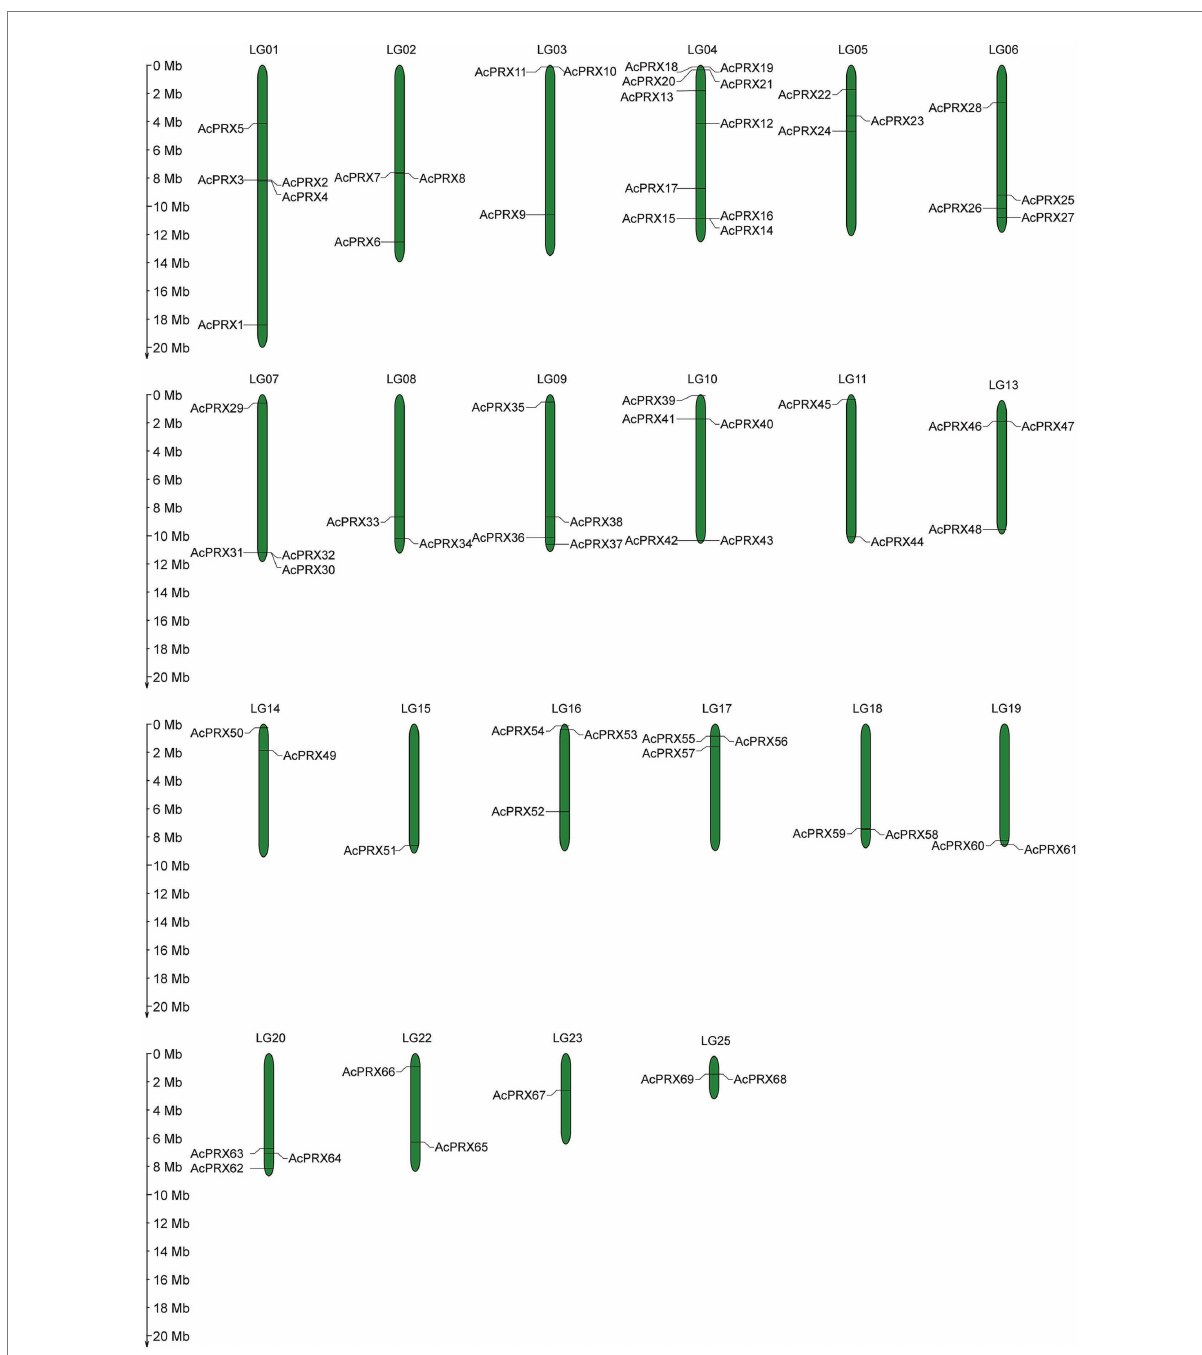
FIGURE 6 Chromosomal distribution of AcPRXs